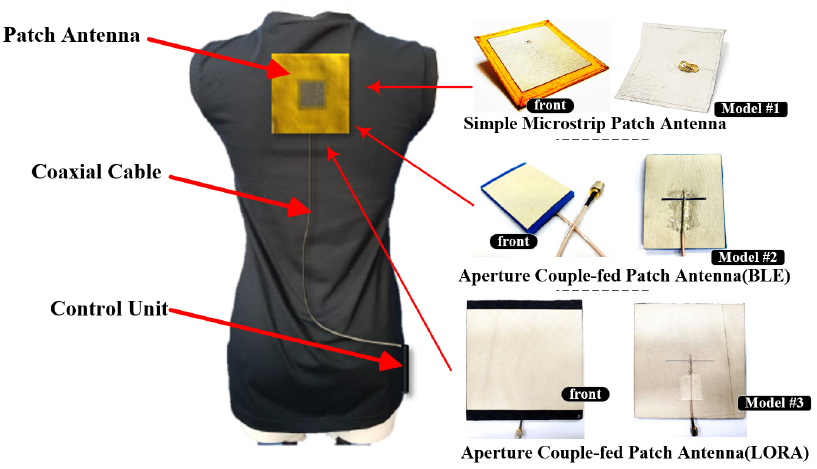
Figure 1. Illustrated view of fabric-based antennas integrated into fabric clothing.